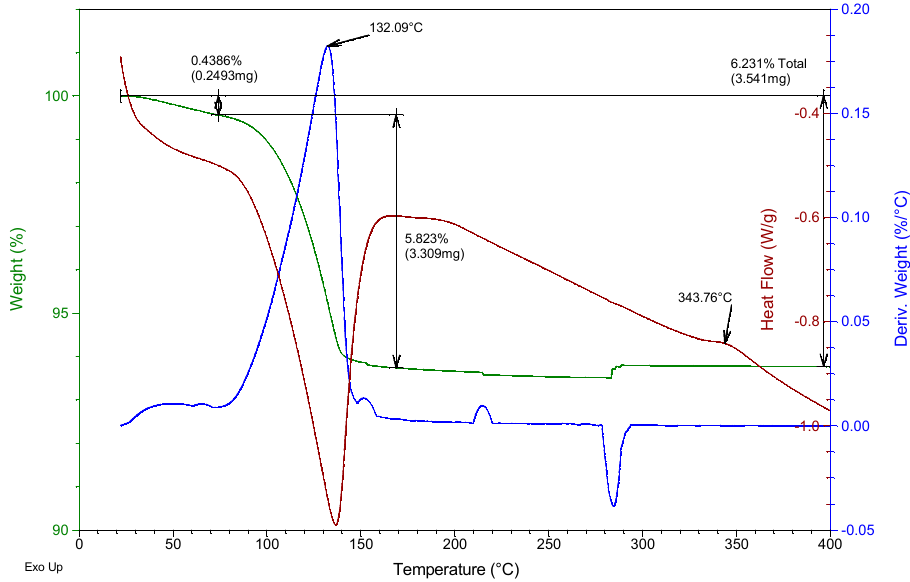
Figure 2. Thermogravimetric analysis of the E35 plaster used.